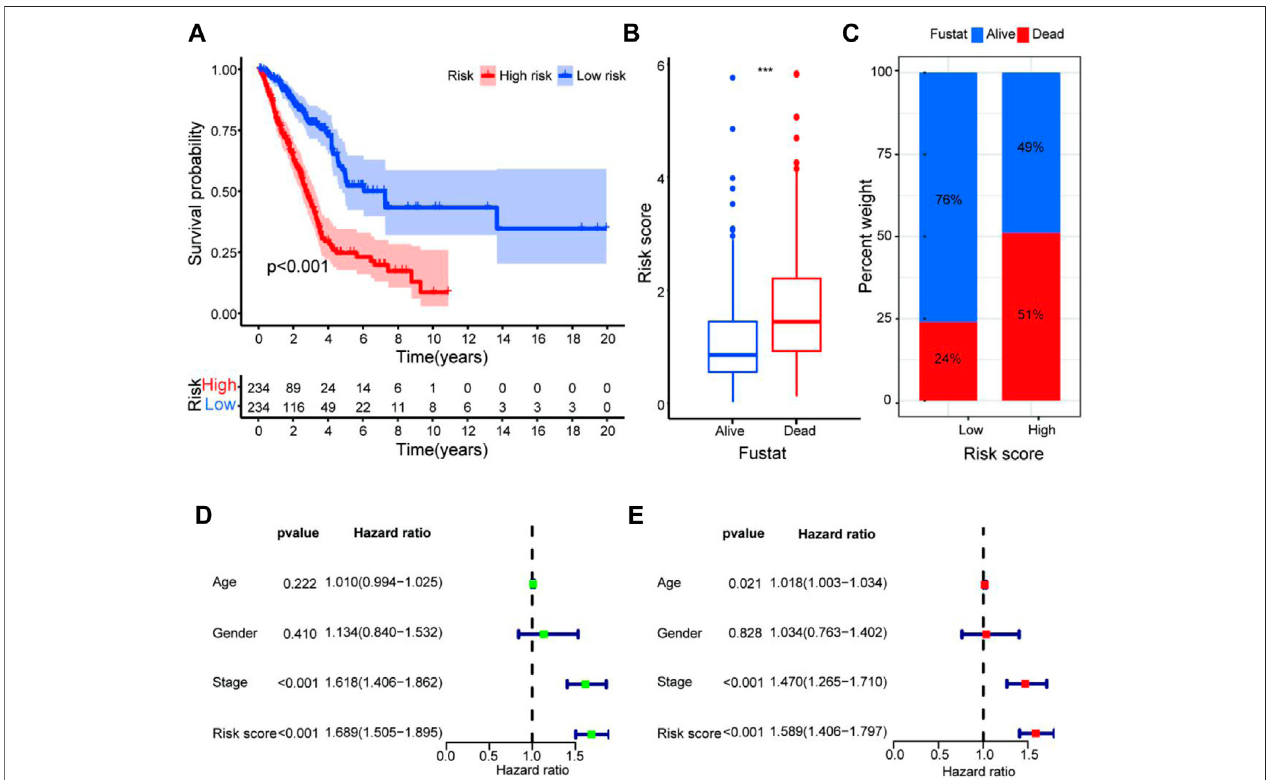
FIGURE 3 | Validation of the predictive value of the prognostic signature. (A – C) The survival curve (A) , boxplot (B) , and barplot (C) indicate that the ARlncRNA signature was associated with survival outcomes of patients with LUAD, and patients with low risk have a signi fi cant survival advantage. (D,E) Univariate (D) and multivariate (E) Coxregression analyses including age,gender,stage, and riskscoresuggestthatriskscore(HR (cid:1) 1.589,CI (cid:1) 1.406 – 1.797, p < 0.001)and stage (HR (cid:1) 1.470, CI (cid:1) 1.265 – 1.710, p < 0.001) could act as an independent prognostic factor for LUAD.